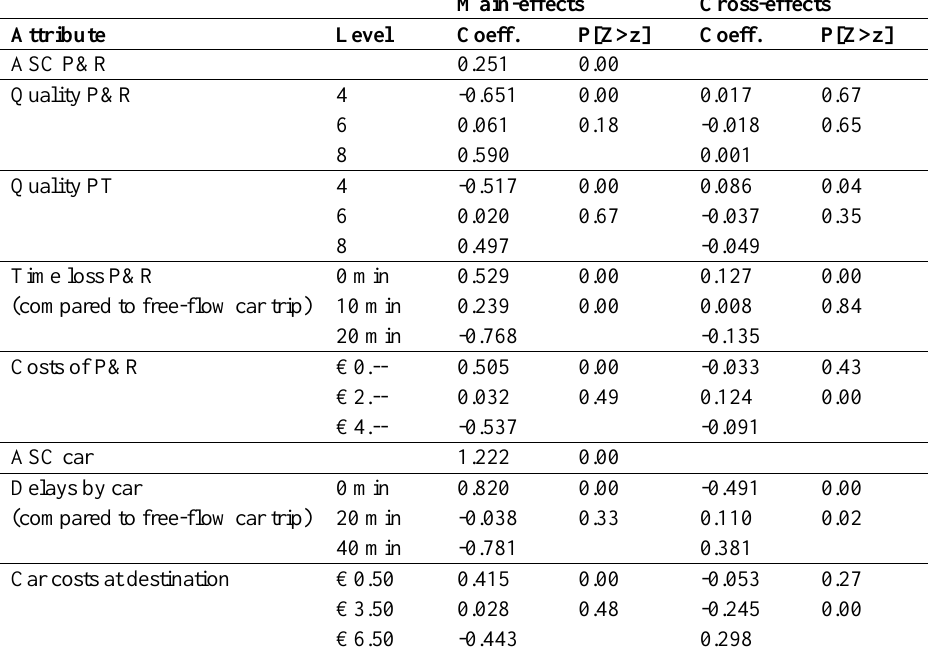
Table 3. Estimated main and cross-effects for